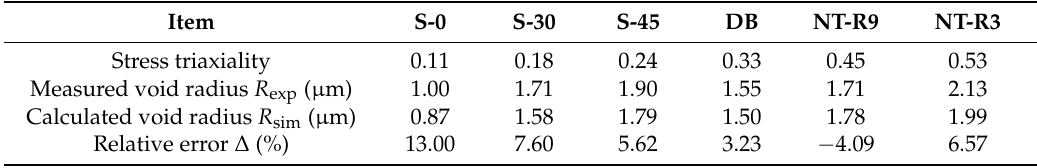
Table 1. Stress triaxiality and measured/calculated void radius of the Rice–Tracey model. Item S-0